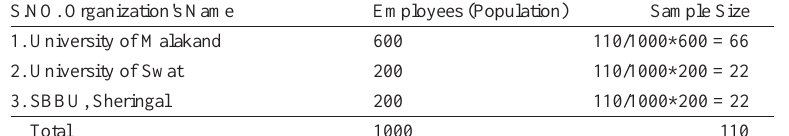
Number of sampled employees in the selected